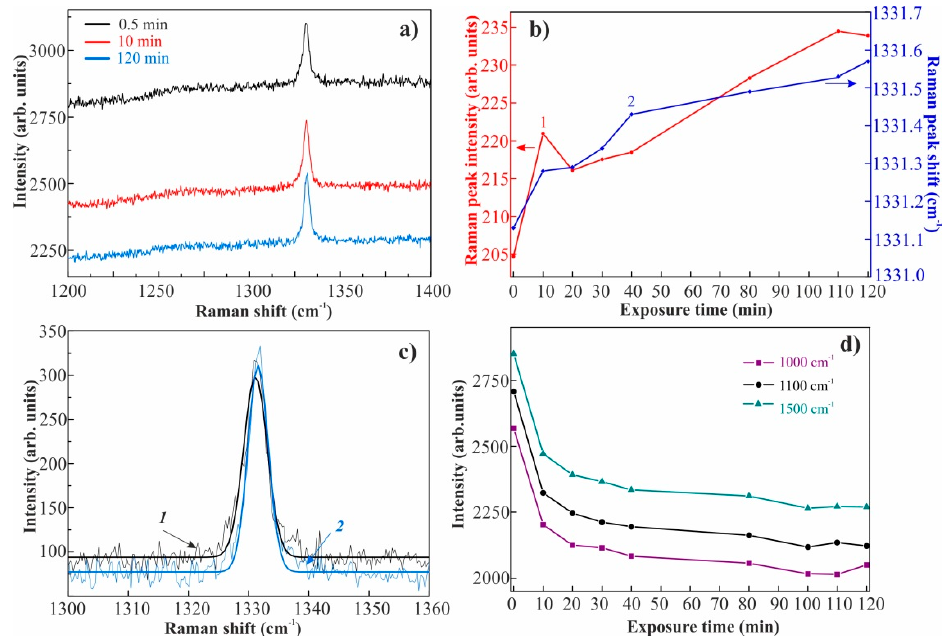
Figure 10. ( a ) Raman spectra of a randomly chosen place of the stationary HP-HT nanodiamond film irradiated by 65 kW/cm 2 laser radiation for different intervals of time (0.5, 10, and 120 min.); ( b ) HP-HT nanodiamond Raman peak intensity and its Raman shift of a randomly chosen place of the stationary film as a function of laser exposure time at 65 kW/cm 2 ; ( с ) Raman spectra of a randomly chosen place of the stationary HP-HT nanodiamond film irradiated by 65 kW/cm 2 laser radiation for intervals of time (curve 1) Δ t = 0.5 min. and (curve 2) Δ t = 120 min. measured at 65 kW/cm 2 excitation intensity after subtraction of baselines with the peaks fitted; ( d ) luminescence intensity at Stokes Raman frequency shifts of 1000, 1100, and 1500 cm -1 of a randomly chosen place of the stationary HP-HT nanodiamond film irradiated by 65 kW/cm 2 laser radiation as a function of laser exposure time.